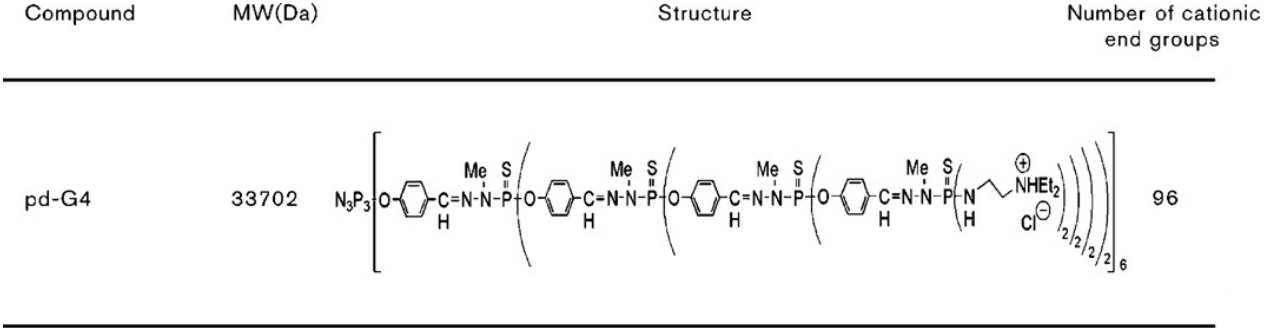
Figure 1. Fourth generation phosphorus-containing